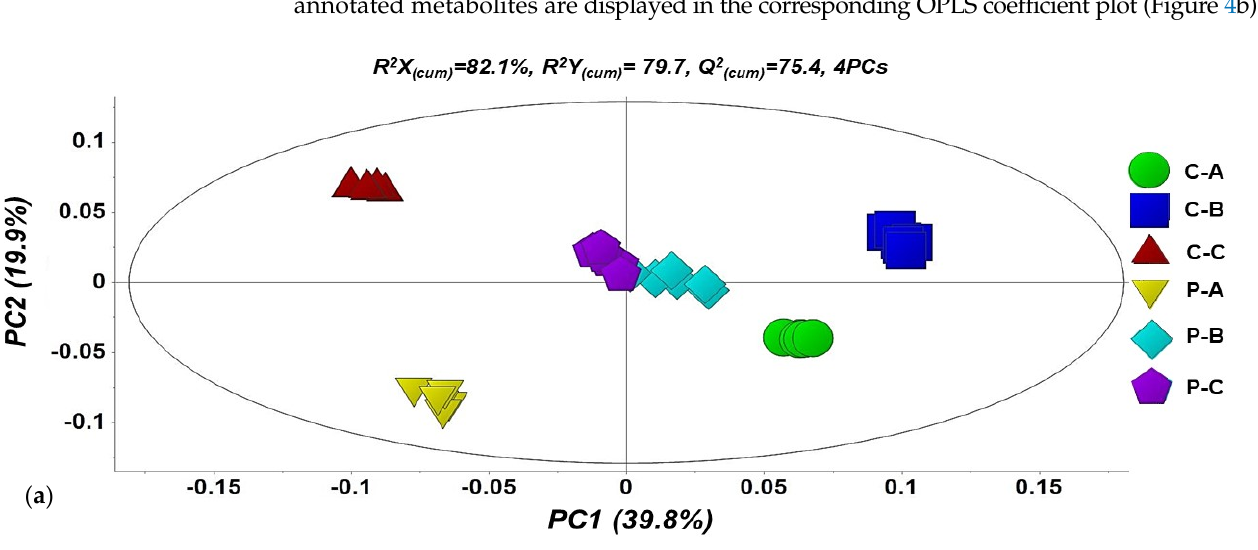
Figure 4. Orthogonal partial least squares-discriminant analysis (OPLS-DA) PC1/PC2 score plot for the GC/EI/MS metabolite profiles of N. tenuis- punctured tomato top, middle, and lower leaves, in comparison to the respective leaves of the untreated plants. The ellipse represents the Hotelling’s T 2 with 95% confidence interval. Six pooled samples were analyzed per treatment (Initial C; control or unpunctured plants, P; plants punctured by predator, A; top, B; middle, C; lower leaves) ( a,b ), and OPLS coefficient plot with values of scaled and centered PLS regression coefficients (Coeffs) for the selected Y variables for the whole dataset. The de novo construction of the metabolic network of N. tenuis- punctured tomato plants was based on data retrieved from the Kyoto Encyclopedia of Genes and Genomes (KEGG, https://www.genome.jp/kegg accessed on 19 June 2020) (Figure 5).